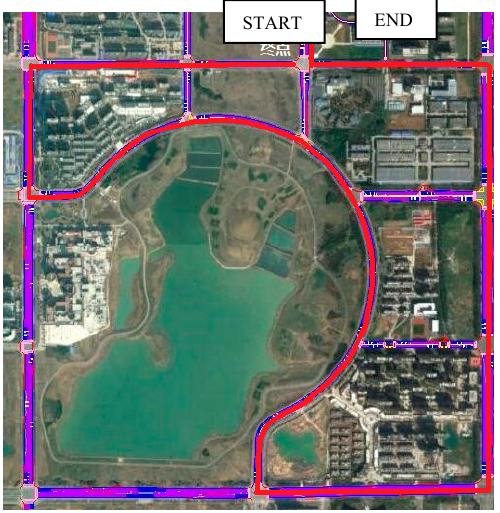
Figure 24. Testing Figure 24. Testing path.